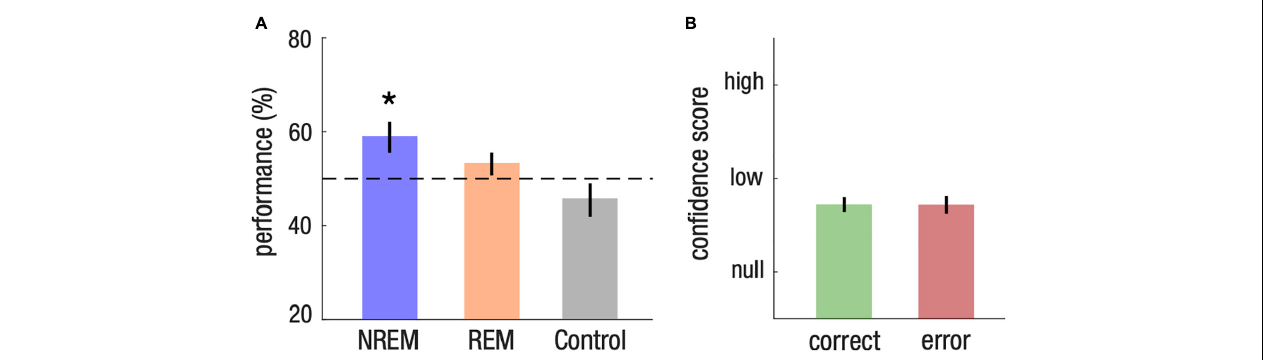
FIGURE 2 | Implicit associative transfer learning for words presented during NREM sleep. (A) Memory performance across NREM, REM and control list. Student’s T-test against chance level (50%, dotted line) were computed for each list and corrected for multiple comparisons (* P < 0.05). (B) Confidence score on a 3-level scale (null, low, high) for memory response of the NREM list. Statistical tests reveal no difference between trials that were successfully identified (correct) and those associated with a mistake (error).